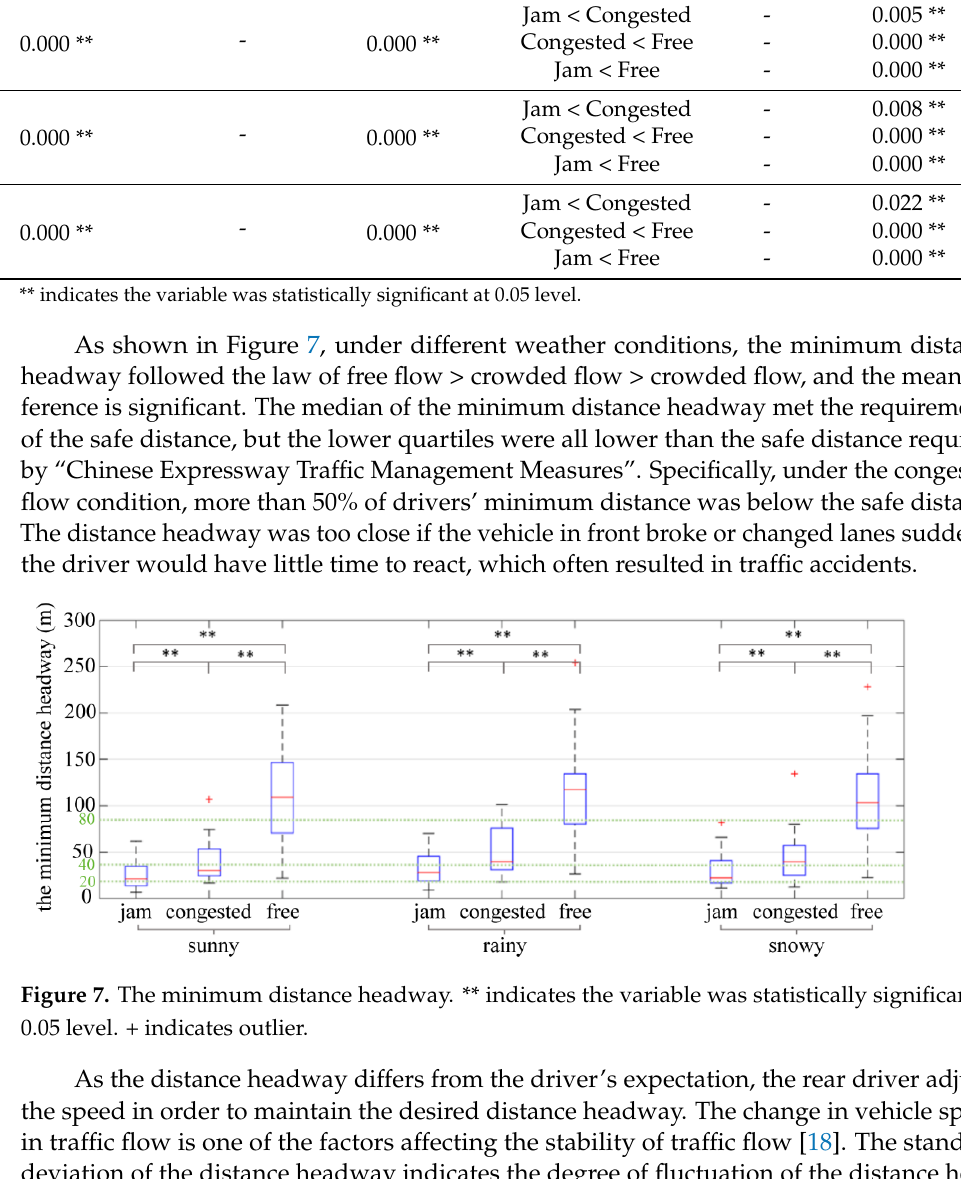
Table 5. Significance test of the influence of traffic flow on the minimum distance headway.